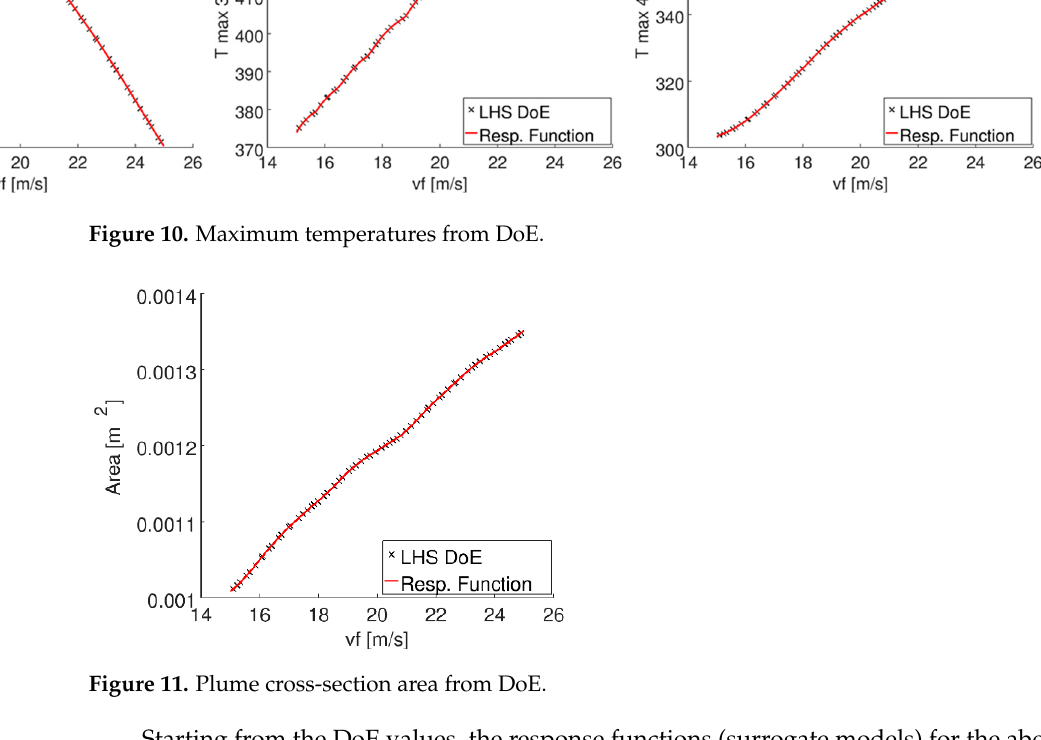
Figure 12. Uniform distribution for the chimney exit flow velocity.